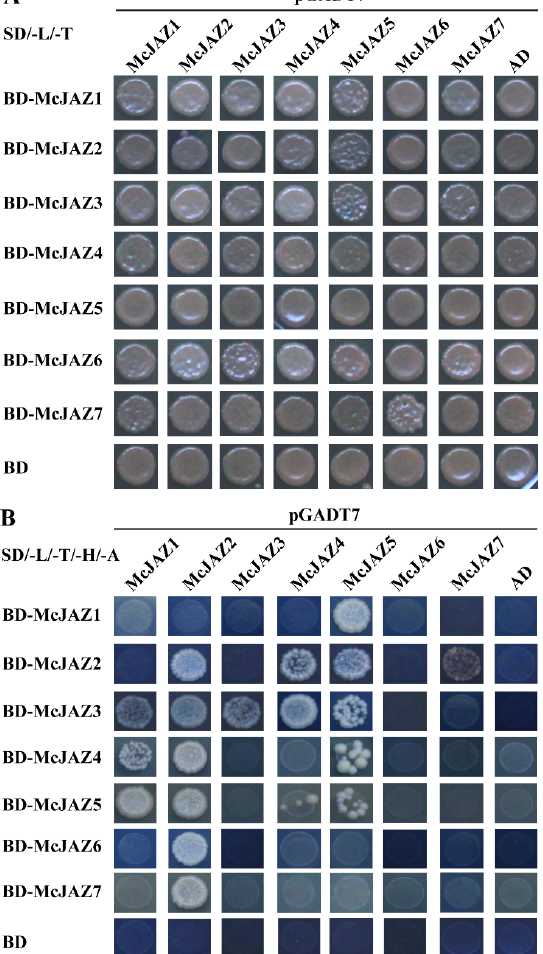
Figure 9. Yeast two - hybrid interactions among different McJAZ proteins. Yeast cells transformed with different combinations of constructs containing McJAZ proteins fused with the DNA binding domain (BD-McJAZ1, BD-McJAZ2, BD-McJAZ3, BD-McJAZ4, BD-McJAZ5, BD-McJAZ6, and BD- McJAZ7), McJAZ proteins fused with the activation domain (AD-McJAZ1, AD-McJAZ2, AD-McJAZ3, AD-McJAZ4, AD-McJAZ5, AD-McJAZ6, and AD-McJAZ7), and the pGBKT7 (BD) alone, and the pGADT7 (AD) alone were inoculated in liquid medium and then placed on control medium SD/- Leu/-Trp (SD/-L/-T) ( A ), and selective media SD/-Leu/-Trp/-His/-Ade (SD/-L/-T/-H/-A) ( B ). The empty vectors (AD and BD) were transformed into yeast and used as negative controls. These data represent three independent experiments, and representative pictures were taken after 4 days of incubation at 30 ◦